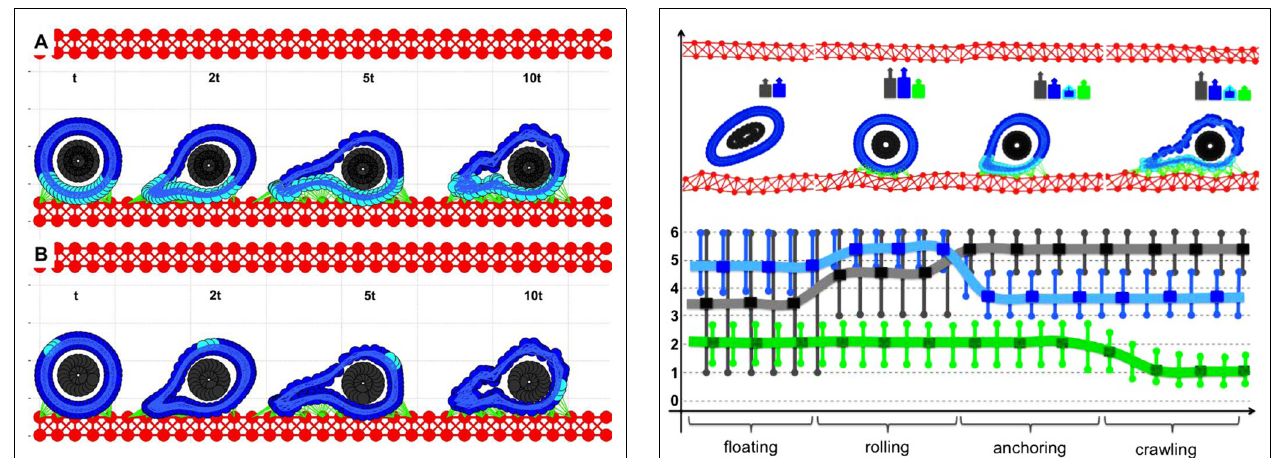
FIGURE 5 | Dynamical changes in the cell cytoskeleton during CTC intravenous transport. Each of the steps of the adhesive cascade requires different cytoskeletal properties of the CTC actin cortex stiffness (blue), cortex stiffness near the adhesion sites (cyan), stiffness of the CTC nuclear envelope (gray), and strength of the CTC–EW adhesion bonds (green). A typical cell configuration for each of the steps of the adhesive cascade is shown in the top row together with a color-coded cell stiffness signature. Lines represent the best continuous fit of the computational data.